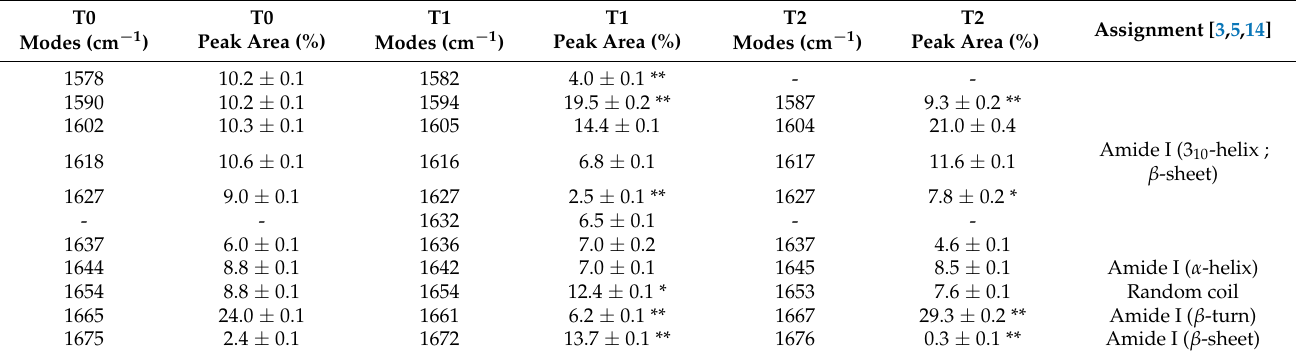
Table 1. Wavenumber position and relative peak areas of the main modes of µ -RS Amide I spectral region of GCF and their assignment. The GCF were collected before starting the orthodontic process (T0 data) and after 2 days of treatment (T1 data) and 7 days of treatment (T2 data). The peak area percentage was evaluated by a fitting procedure, assuming the Amide I band area equal to 1. The area values are shown as ‘mean ± standard deviation’ for each